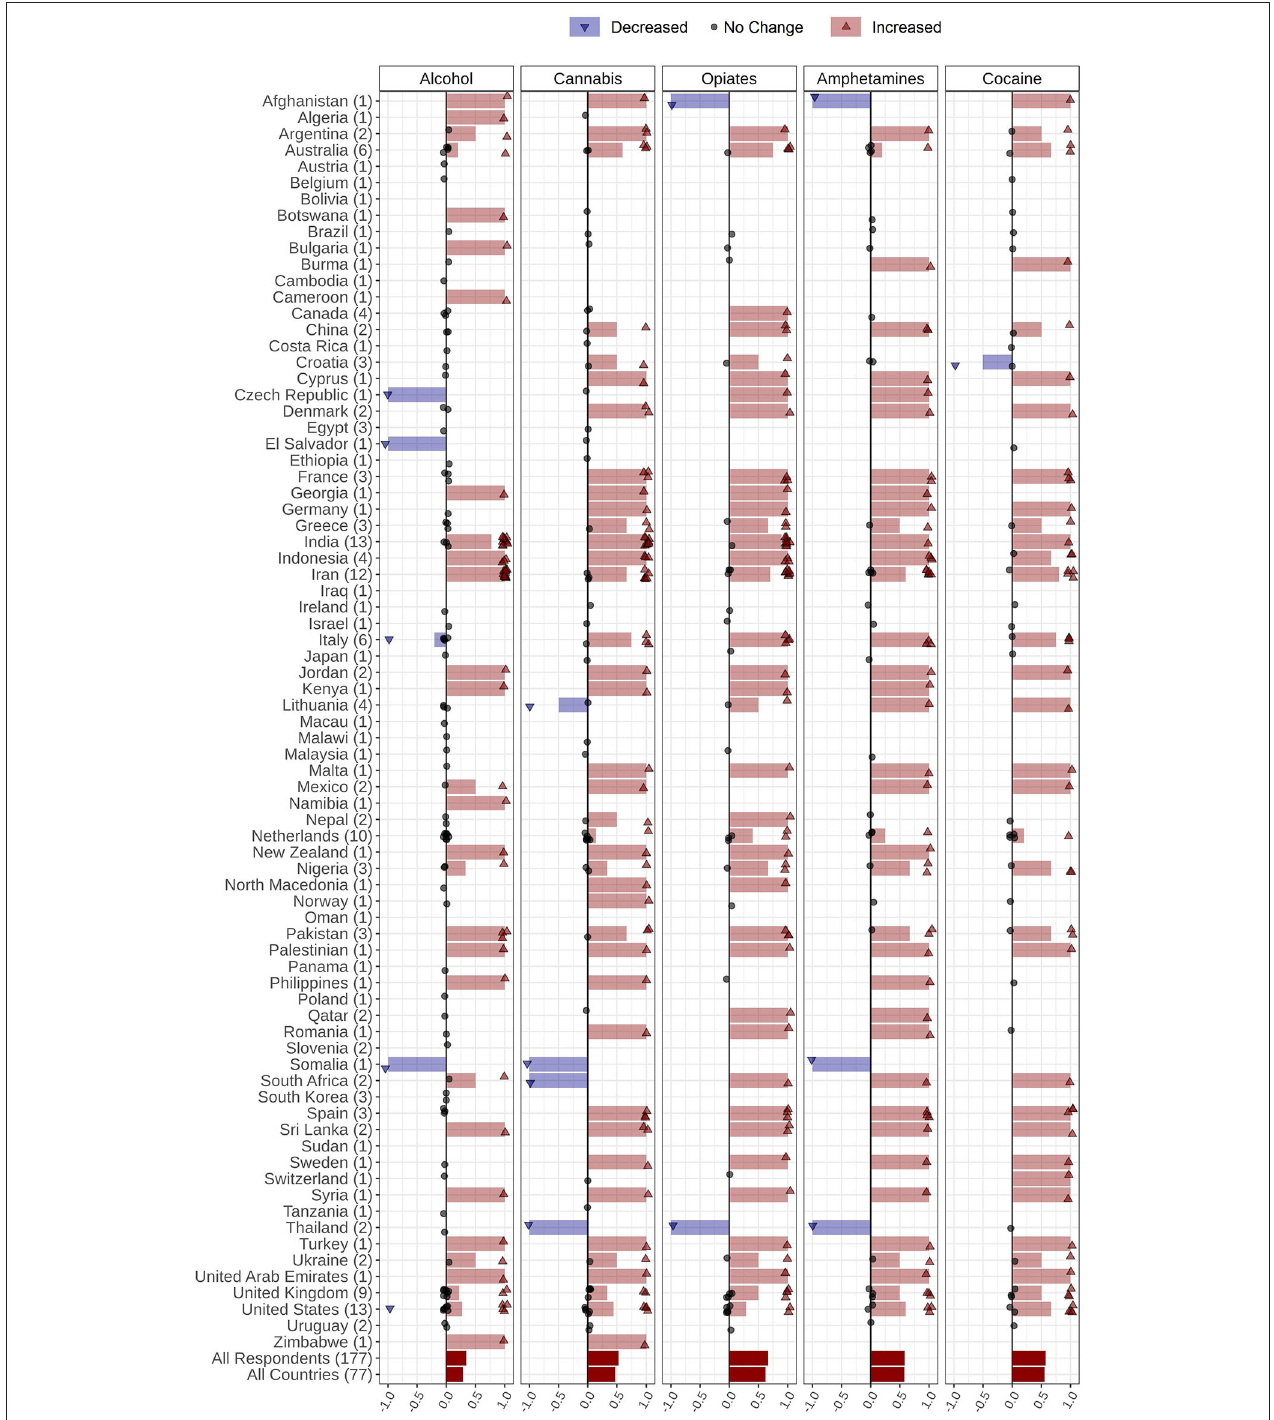
FIGURE 4 | Changes in alcohol and drug prices during the COVID-19 pandemic reported by 177 respondents from 77 countries globally. Respondents were asked to report changes in alcohol, amphetamines, cannabis, and opiates prices through the following options: Price increased, Price decreased, Price did not change, and I do not know. Countries’ names are sorted in alphabetic order, and the number of respondents from each country is in parentheses following the country name. Each response is indicated as a single dot for no change or up and down triangles for increased and decreased answers, respectively, with a minor jitter for better visualization. Reported answers are represented as − 1 for decreased , 1 for increased , and 0 for no change; I do not know answers are not shown in the figure. The mean of all responses, regardless of their originated countries and without considering those who did not know the answer, alongside the average answers of all countries, regardless of the number of respondents in each country, are addressed in the last two rows below the countries’ names.